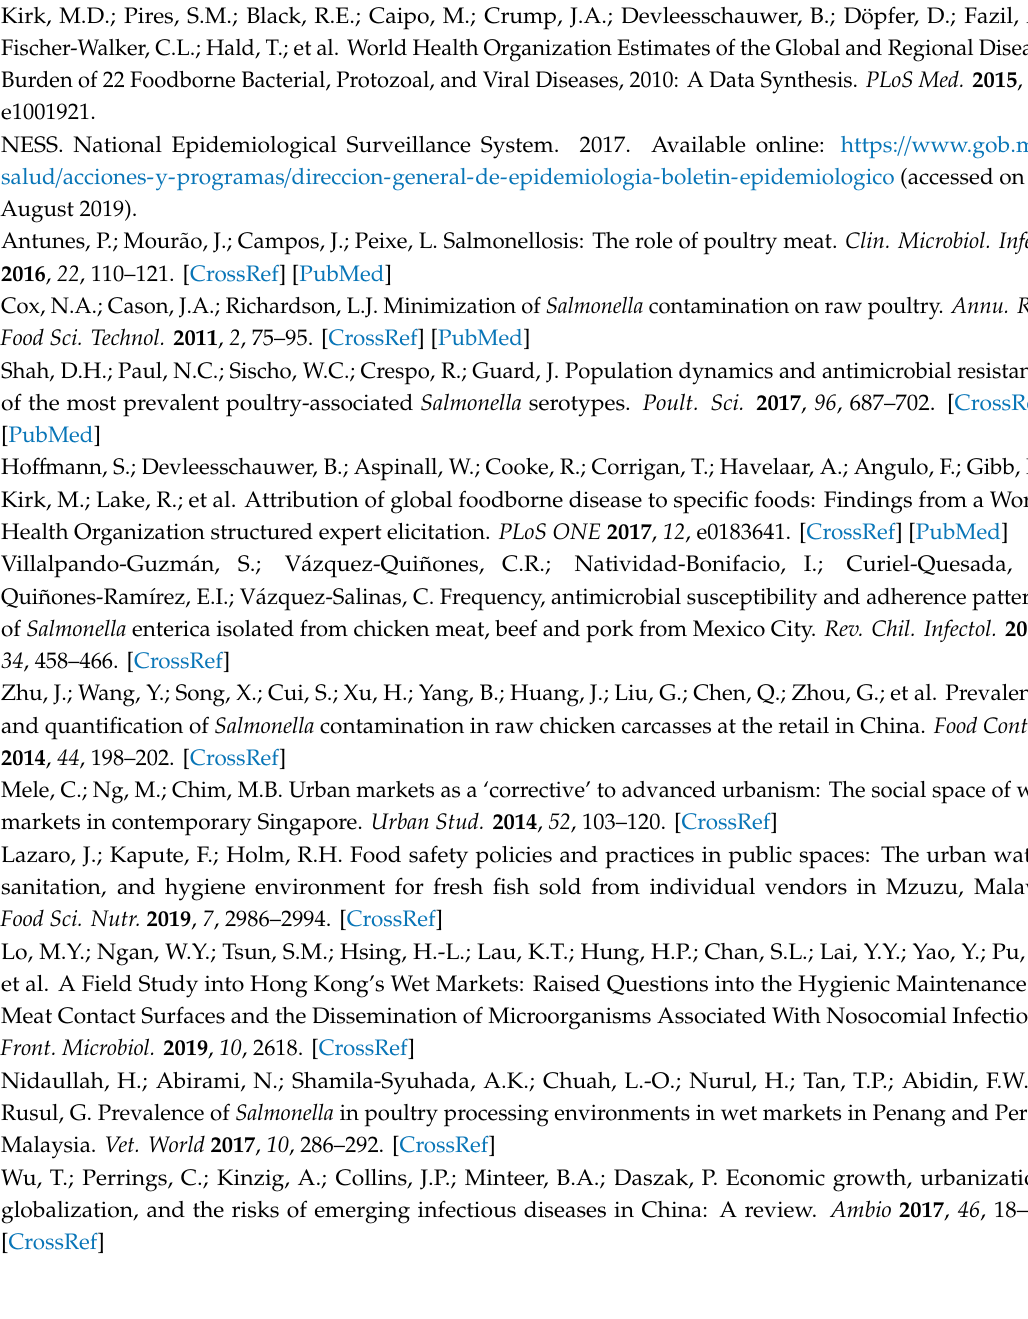
meat. Figure S2: Correlation between Salmonella prevalence in retail chicken meat and human salmonellosis cases. Table S1: Salmonella Prevalence over time. Table S2: Seasonal e ff ect on Salmonella prevalence per year. Table S3: Odds ratio analysis of the Salmonella prevalence over